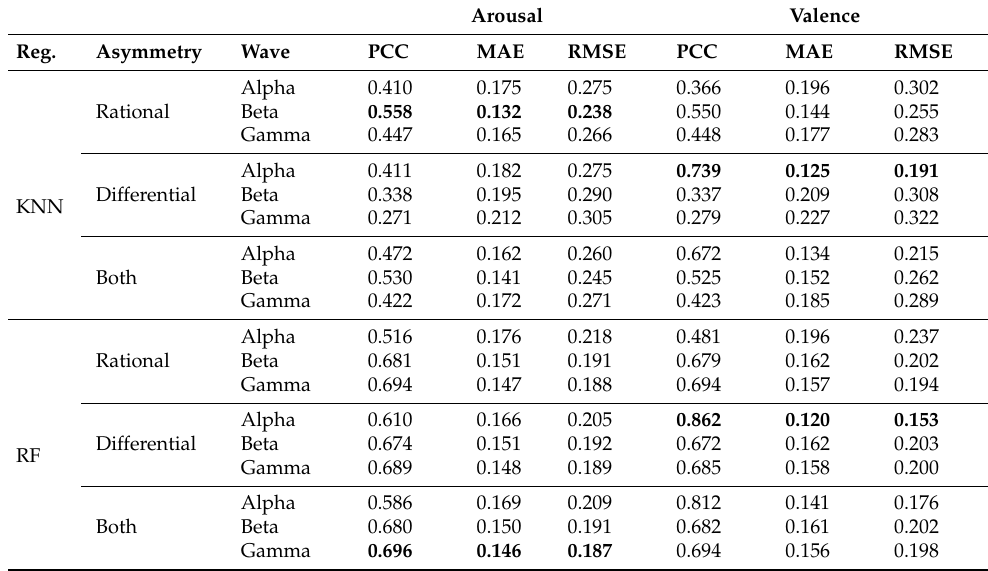
Table 4. Results for two types of asymmetry, and their combination, per wave. Bold values represent the best results for KNN and RF on each column.